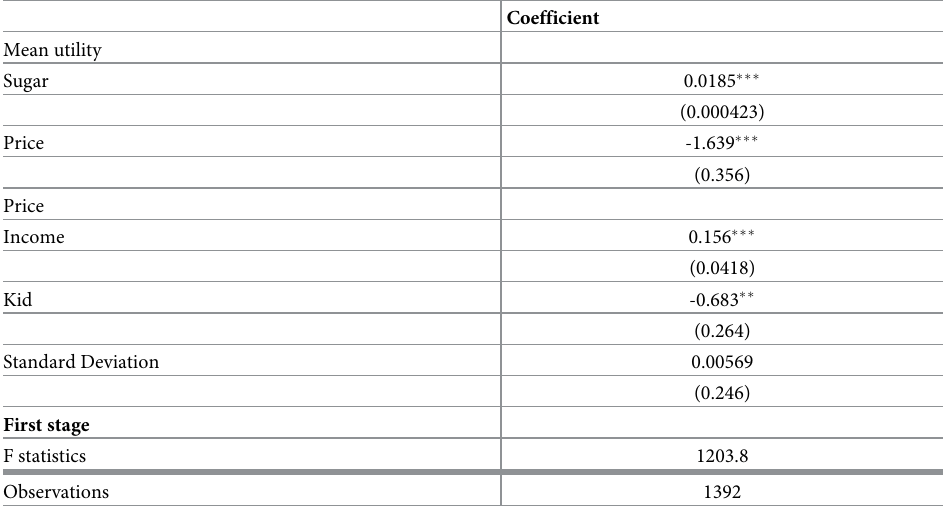
Table 2. Estimated coefficients of the demand